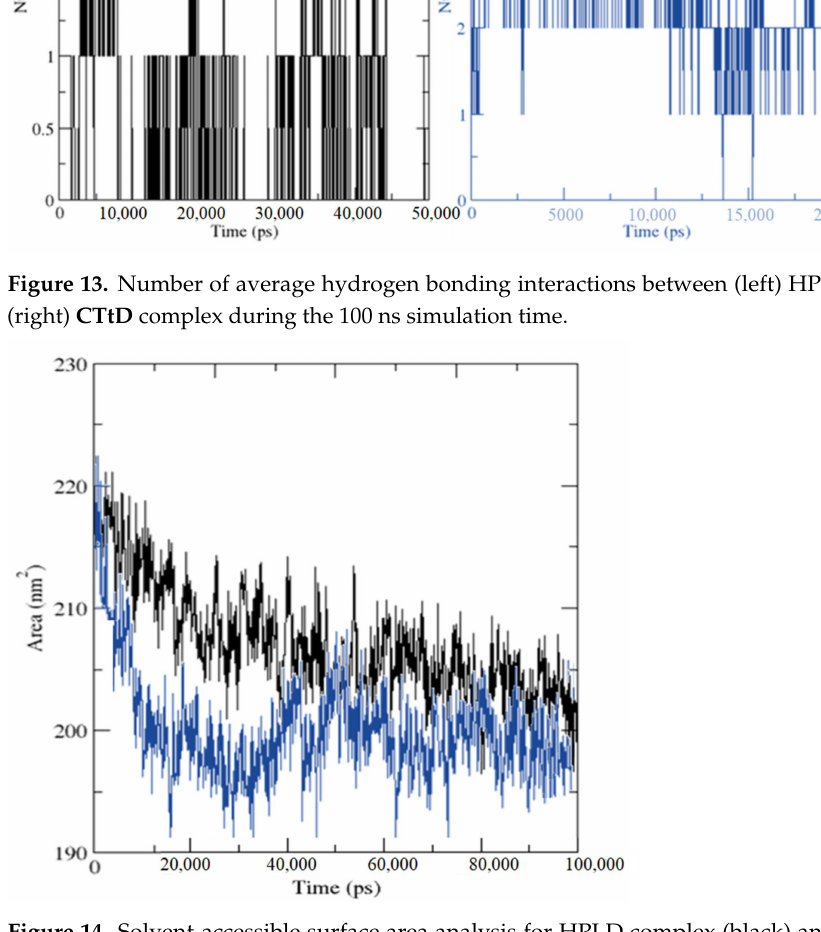
Figure 14. Solvent-accessible surface area analysis for HPLD complex (black) and CTtD complex (blue) during the 100 ns simulation